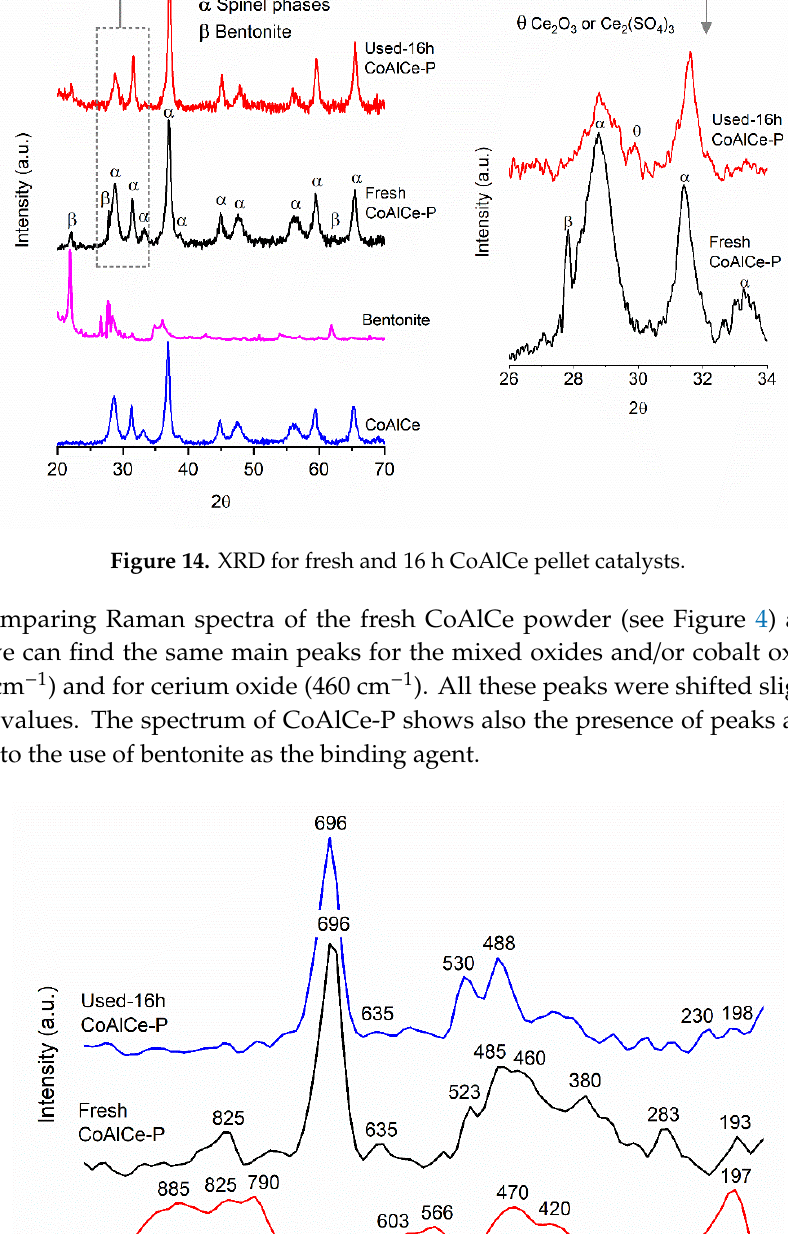
Figure 15. Raman spectra for fresh and 16 h CoAlCe pellet catalysts.